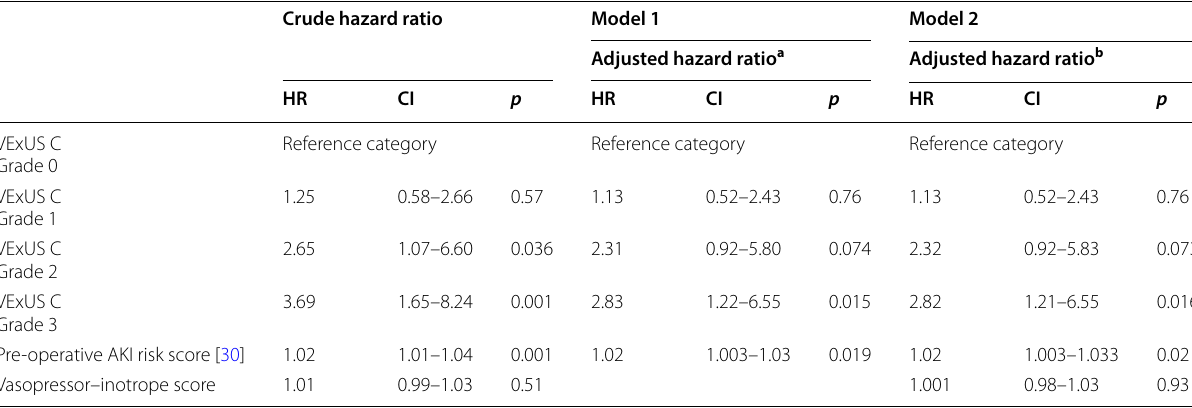
Multivariable proportional hazard regression model (Cox) with the VExUS grade considered as a time‑varying covariate (i.e., VExUS grade at day 0 is used to predict AKI at day 1, VExUS grade at day 1 is used for AKI at day 2 and so on). HR hazard ratio, CI 95% confidence intervals a Variables included in the multivariate model were the VExUS C grade (segmented time‑dependant) and pre‑operative AKI risk score [30] b Variables included in the multivariate model were the VExUS C grade (segmented time‑dependant), vasopressor–inotrope score (segmented time‑dependant) and pre‑operative AKI risk score